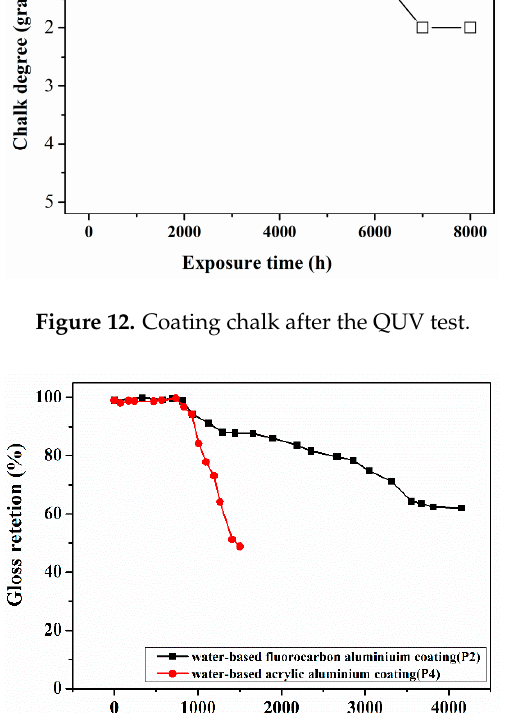
Figure 13. QUV test of coatings of P2 and P4 with 5% aluminum powder.